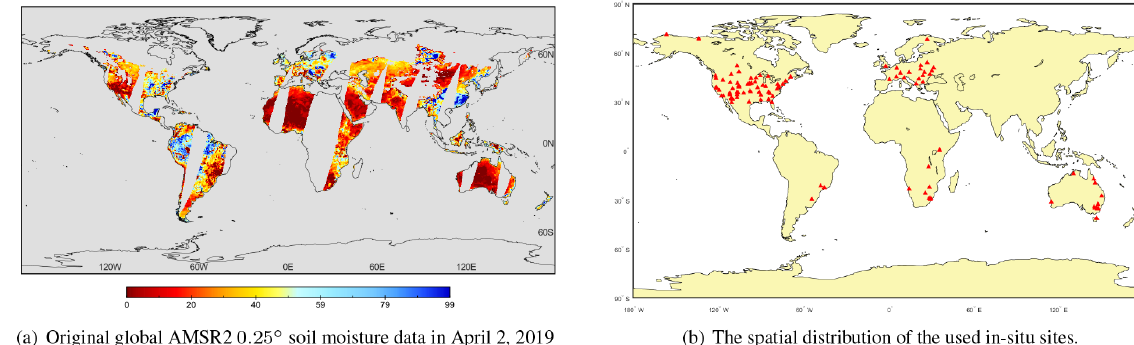
Figure 1. AMSR2 soil moisture product and selected in situ soil moisture sites.